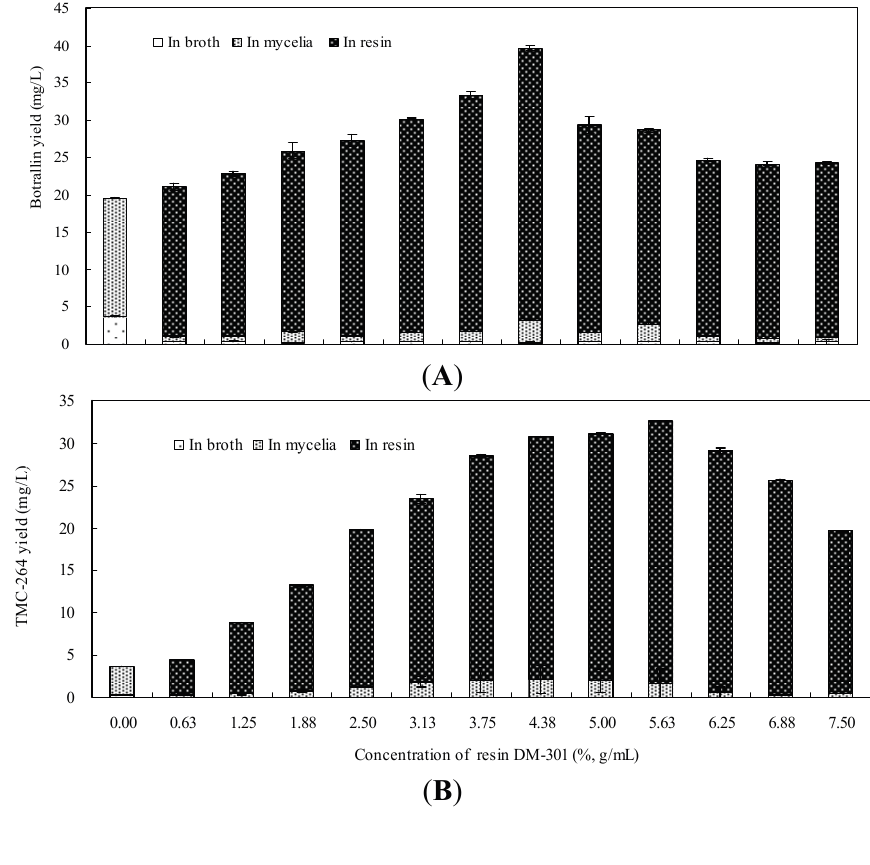
Figure 3. Effects of DM-301 resin at its different concentrations on production of botrallin ( A ) and TMC-264 ( B ) along with their distribution in the broth, mycelia and resins in liquid culture of Hyalodendriella sp. Ponipodef12 (error bars for standard deviations, n =